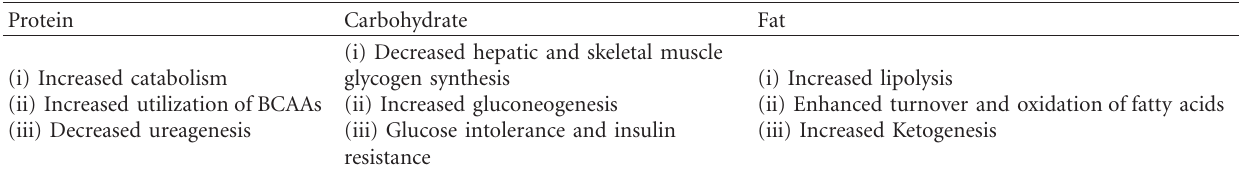
Table 1: Metabolic alterations leading to malnutrition in end-stage liver